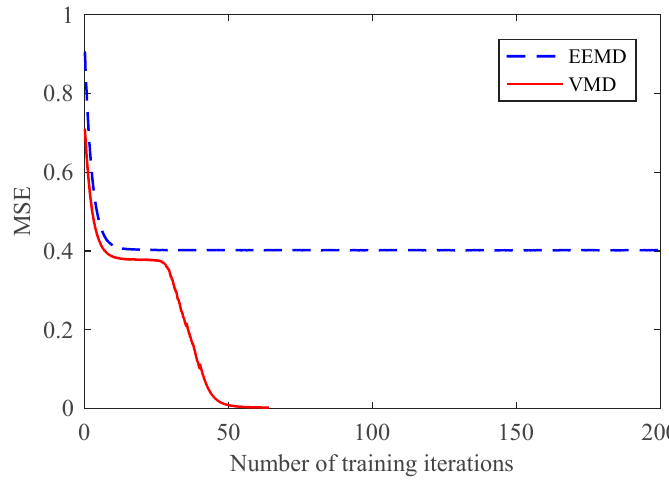
Figure 16. CNN MSE curves of breakage degradation. Table 5. Recognition rate of breakage degradation with training 70 times.